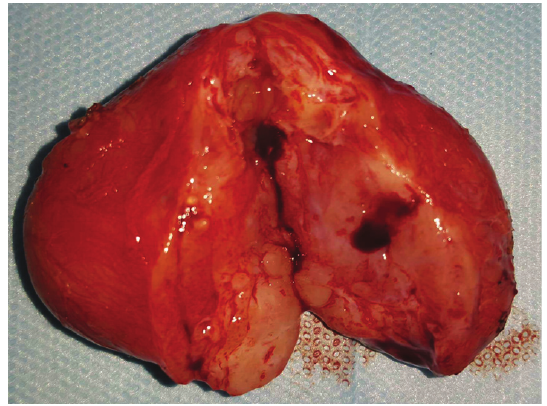
Figure 4. The resected benign